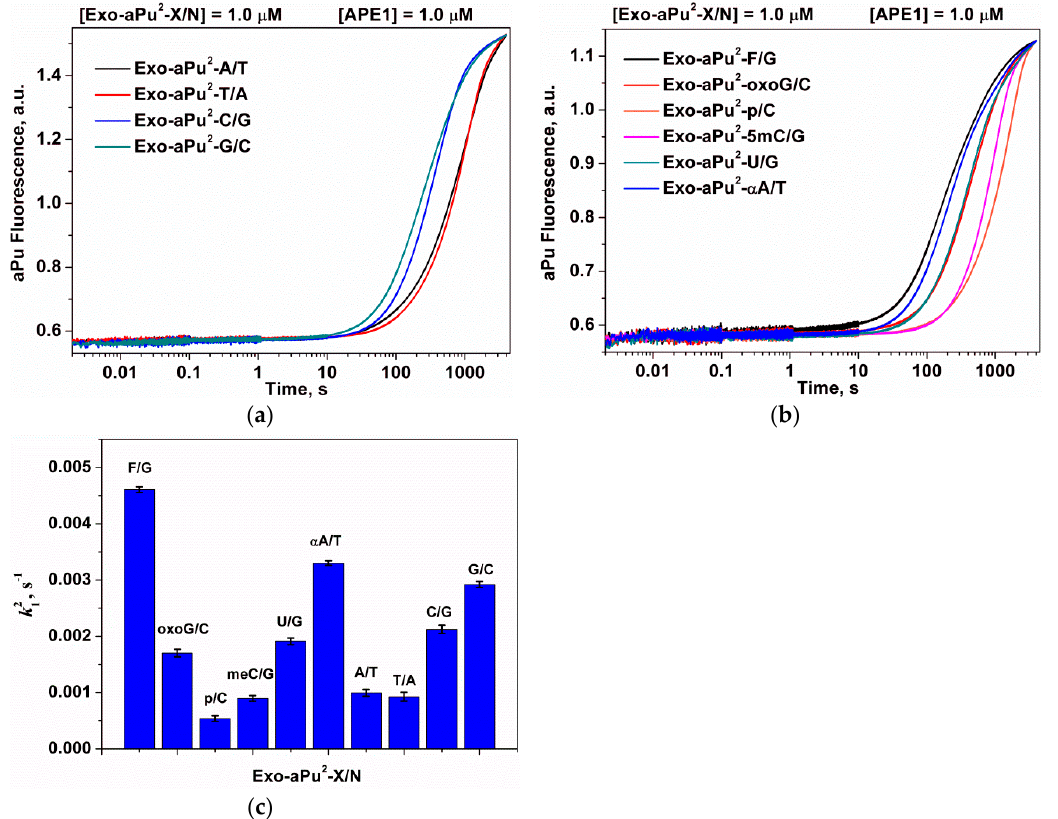
Figure 8. A change in the intensity of aPu in the course of APE1 interaction with substrates Exo-aPu 2 -X/N that contain an undamaged ( a ) or damaged ( b ) 3 ′ -end nucleotide. ( c ) The values of the observed rate constants k i2 , X/N -pair is depicted in figure. [APE1] = 1.0 μ M, [ Exo-aPu 1 /N ] = 1.0 μ M.